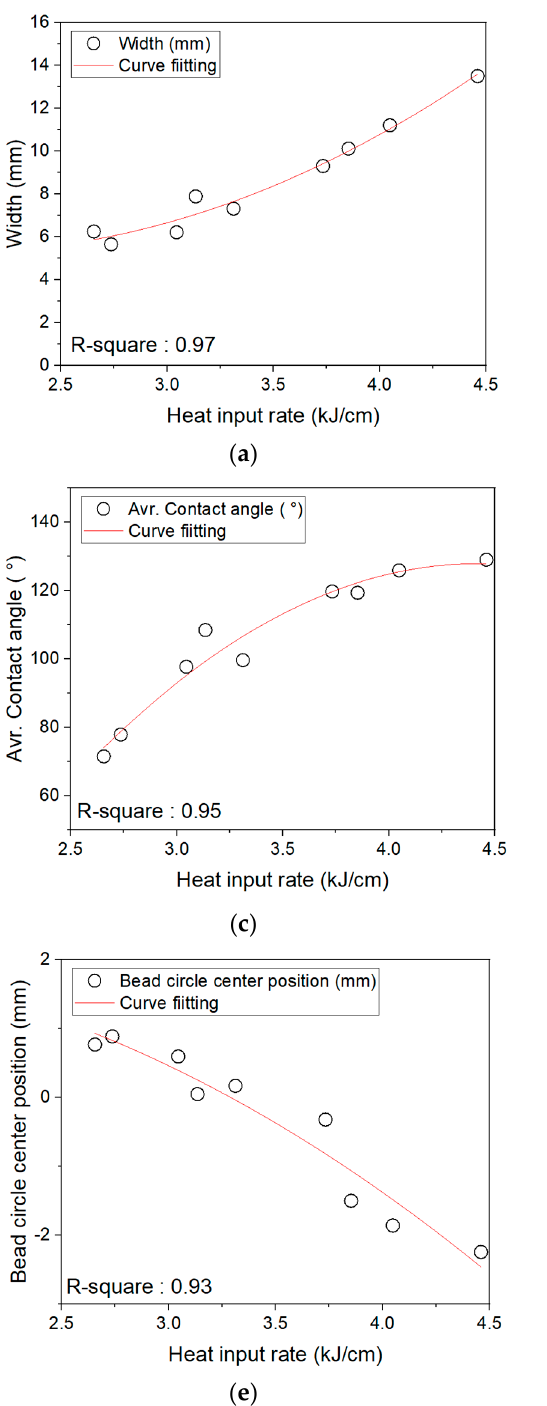
Figure 6. Geometry fluctuation of beads according to heat input rate. ( a ) Width fluctuation according to heat input rate. ( b ) Height fluctuation according to heat input rate. ( c ) Contact angle fluctuation according to heat input rate. ( d ) Bead radius fluctuation according to heat input rate. ( e ) Circle center position fluctuation according to heat input